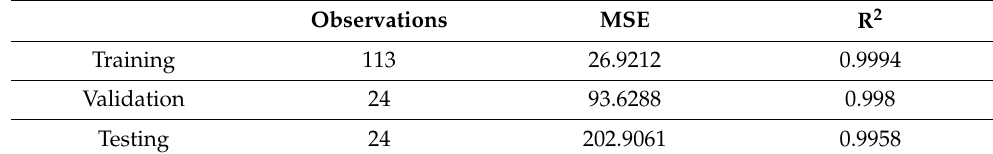
Table 3. Performance of developed ANN model for the chemical explosion.